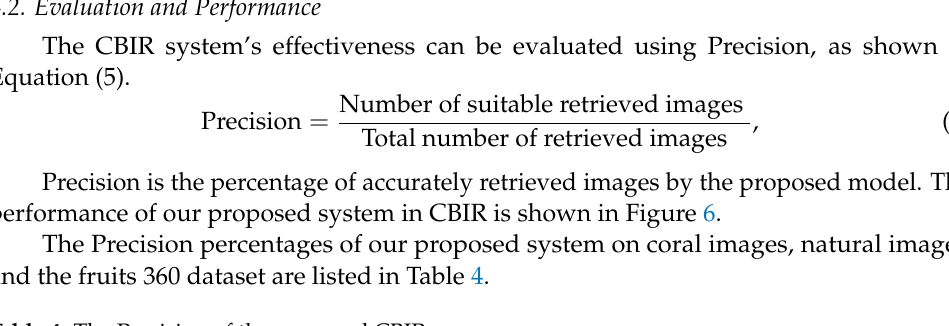
Table 4. The Precision of the proposed